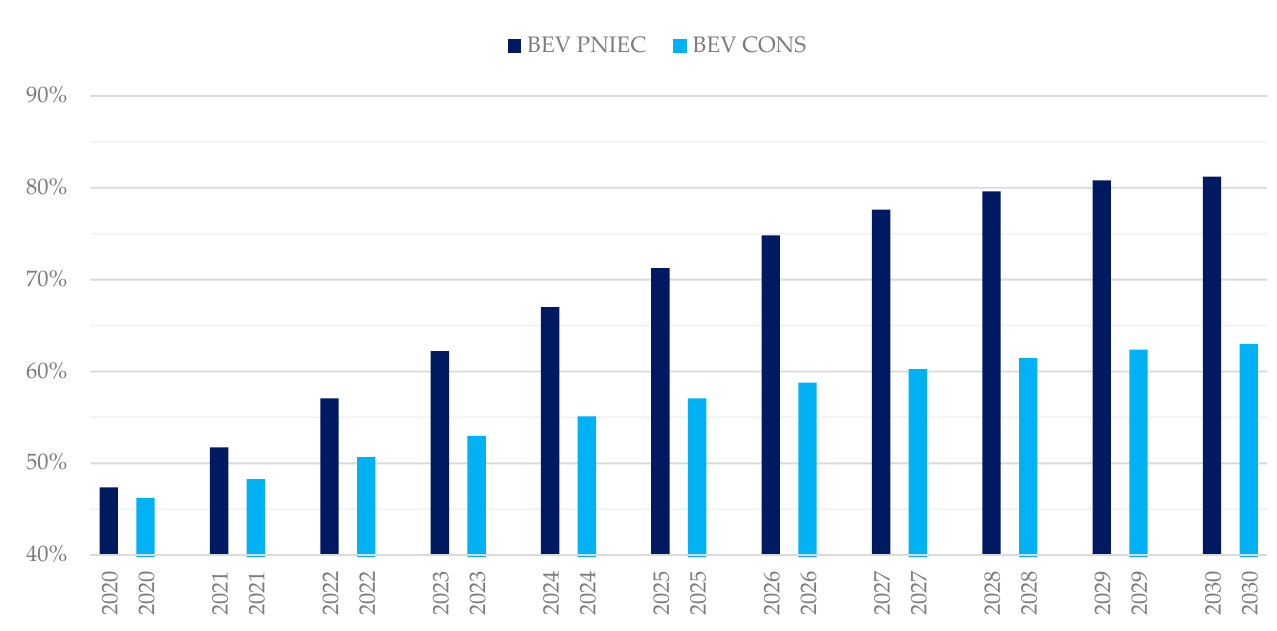
Figure 17. EV penetration index forecast for Rome–Fiumicino airport for rental cars.